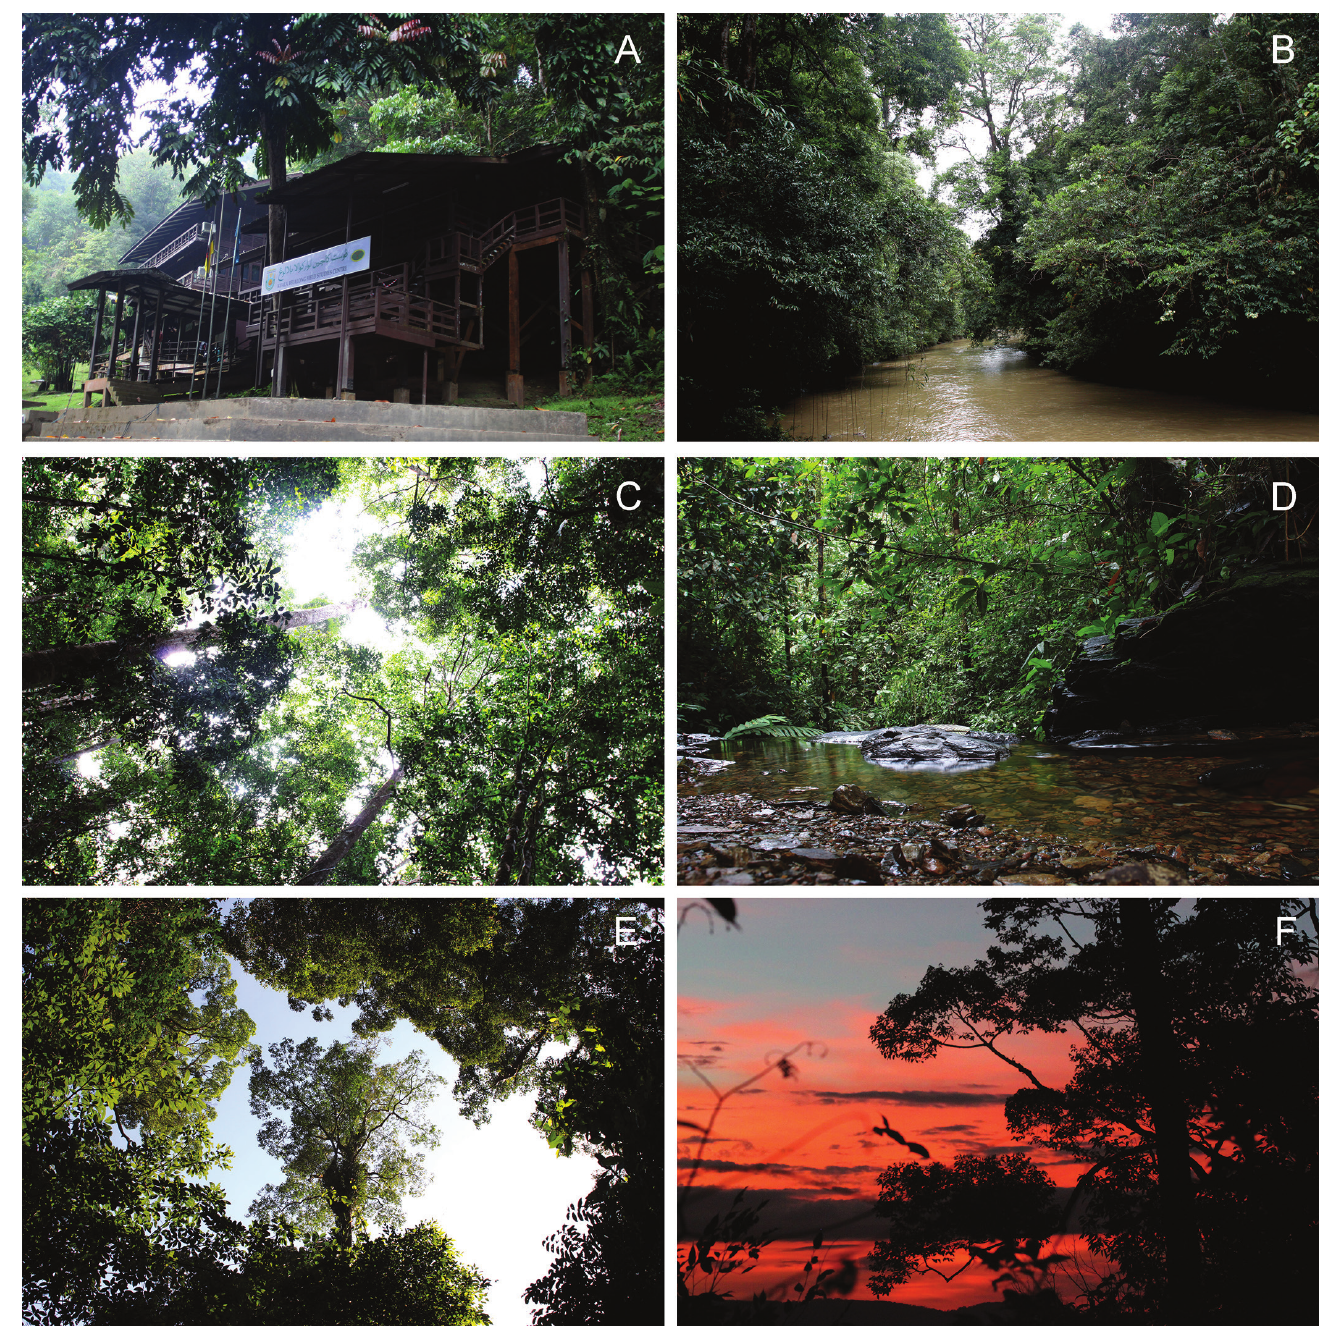
Fig. 2. Environment of KBFSC and surrounding habitats: A. View of the KBFSC from Sungai Belalong; B. View of Sungai Belalong from KBFSC; C. Afternoon view of the canopy on the ridge along Ashton Trail; D. Sungai Mata Ikan, a small forest stream near KBFSC; E. Morning view of the canopy at Ulu Temburong National Park; F. Dusk time at the Canopy